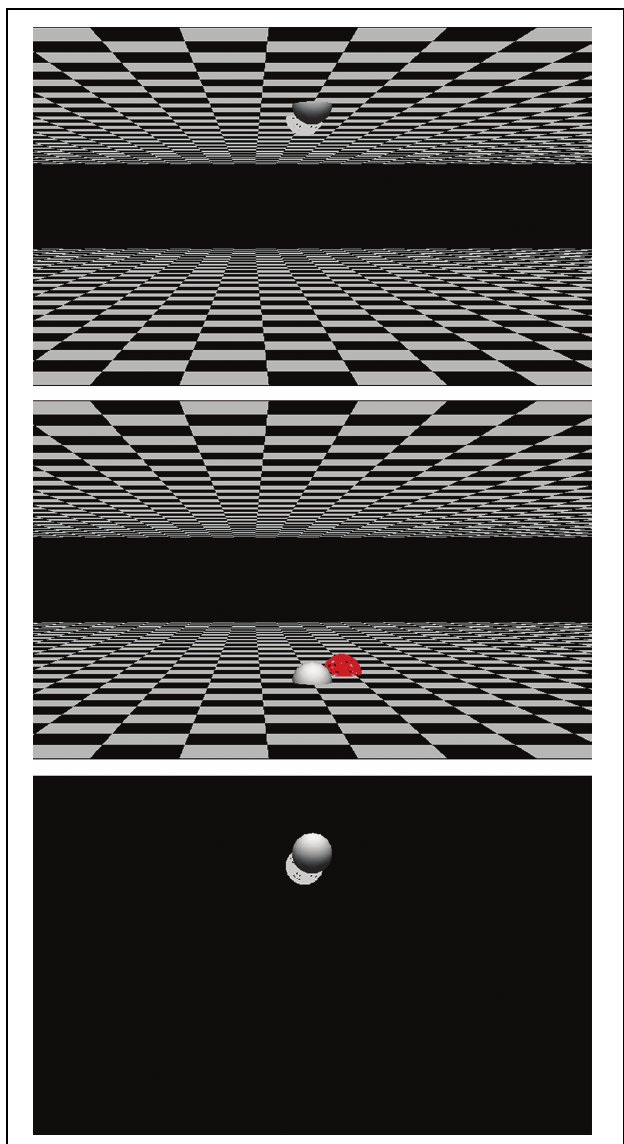
FIGURE 3 | Examples of stimuli. Solid spheres are fixation and wired spheres are target stimuli. (top,middle) : Stimuli in Experiment 1. (bottom) : Stimulus in Experiment 2. The location of the target in the (bottom) is the same as that in the (top) in the experiment They were 3-dimensionally provided through a stereo shutter